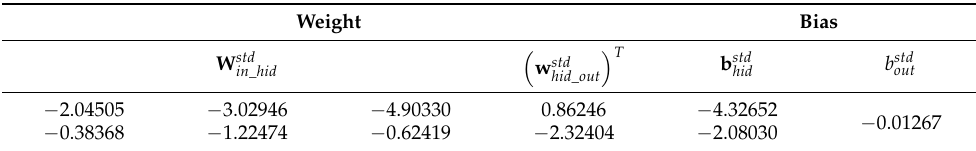
Table 4. Weight and bias terms of the NN for the estimated process standard